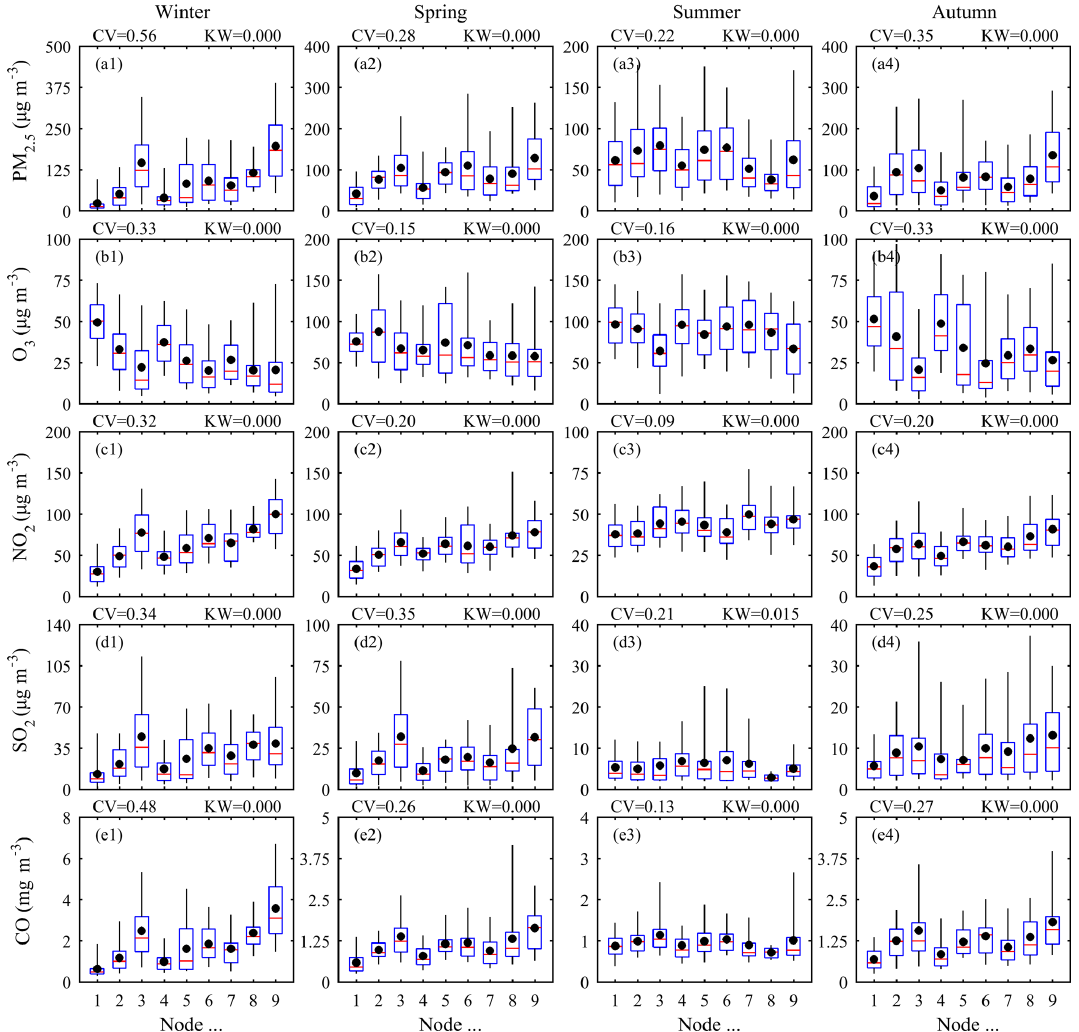
Figure 5. Daily concentrations of (a) PM 2 . 5 , (b) O 3 , (c) NO 2 , (d) SO 2 and (e) CO in Beijing for all nine ABL types separately in (1) winter, (2) spring, (3) summer and (4) autumn. The solid dots denote the mean. The box and whisker plot presents the median, the first and third quartiles and the 5 and 95th percentiles, respectively. The numbers above the plots denote the results of the Kruskal–Wallis test (KW) and the coefficients of variation (CV) of pollutant means across the various